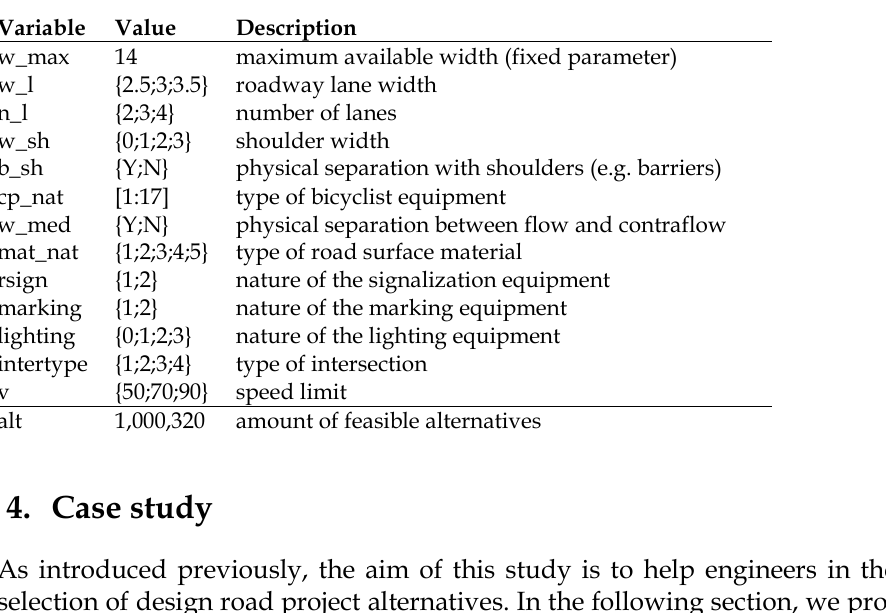
Table 3. Amount of alternatives for a simplified problem